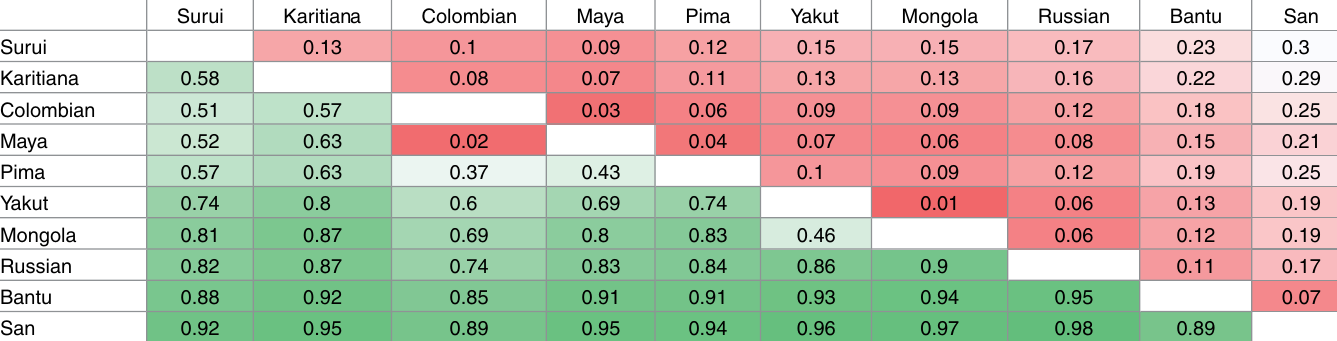
Table 1. Pairwise F ST (above diagonal) and E ST (belowdiagonal) in 5 New World and 5 Old World HGDP populations.